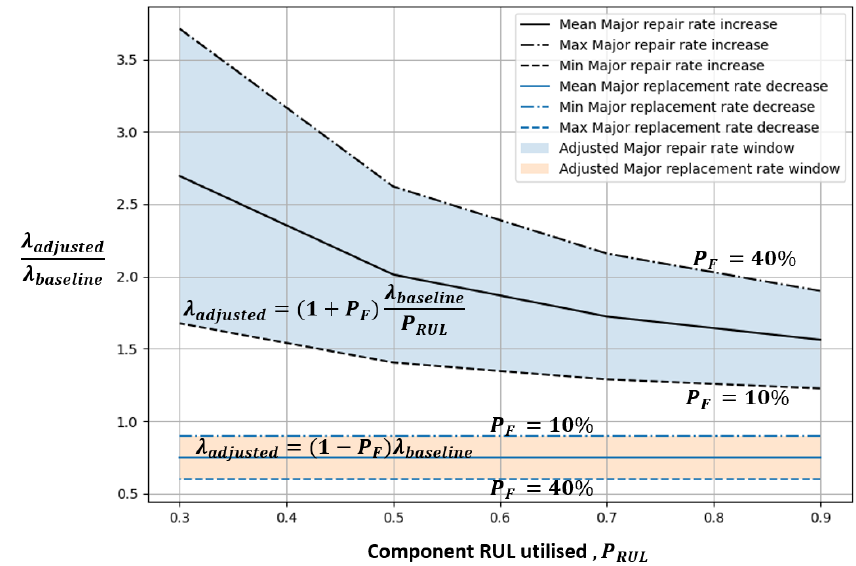
Figure 3. Adjusted failure rates.